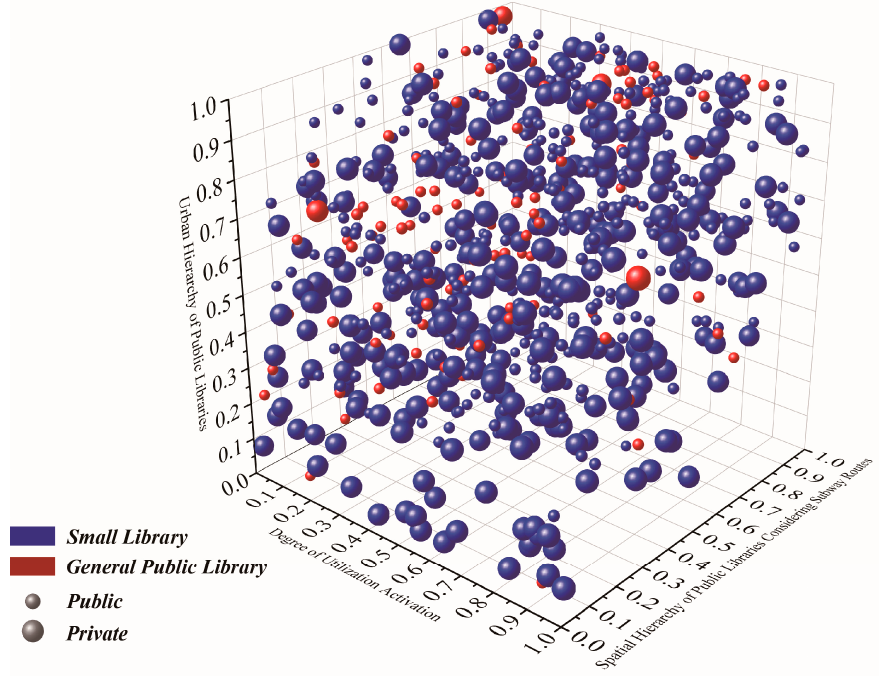
Figure 7. The integration of public libraries in Seoul: ( a ) axial map integration graph; ( b ) convex space integration graph.